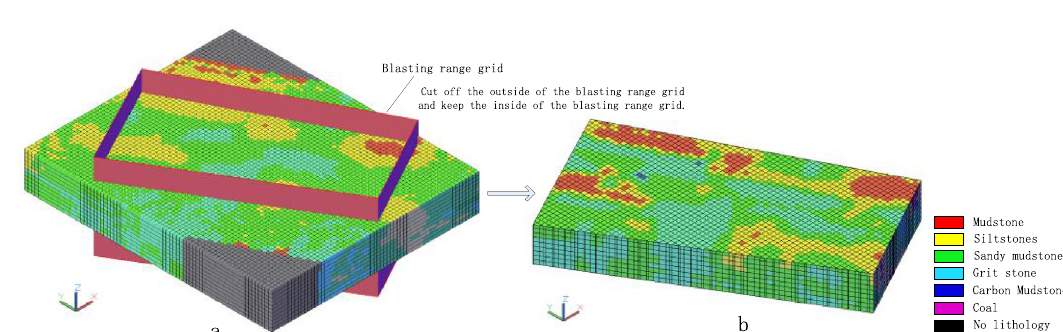
Figure 8. Cutting process of blasting range grid: ( a ) Blasting range grid; ( b ) 3D solid model after